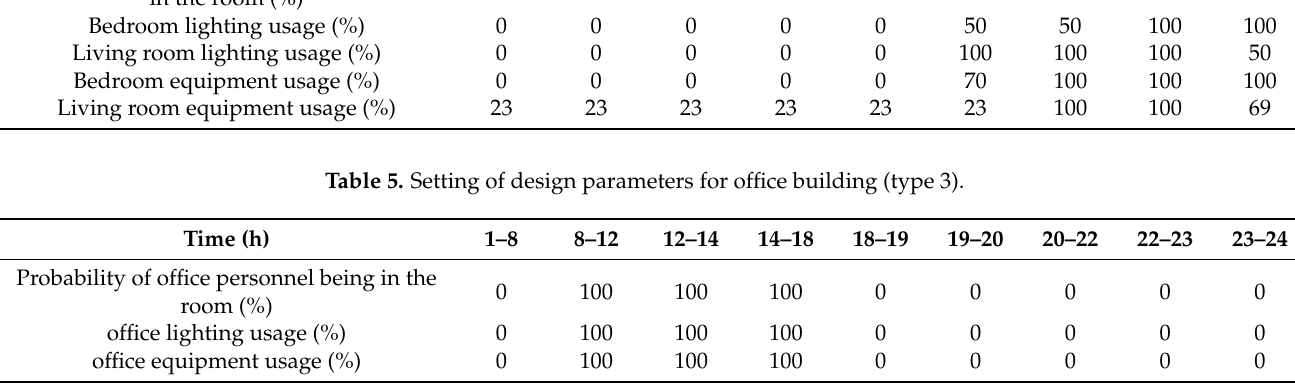
Table 6. Typical building envelope parameter setting.